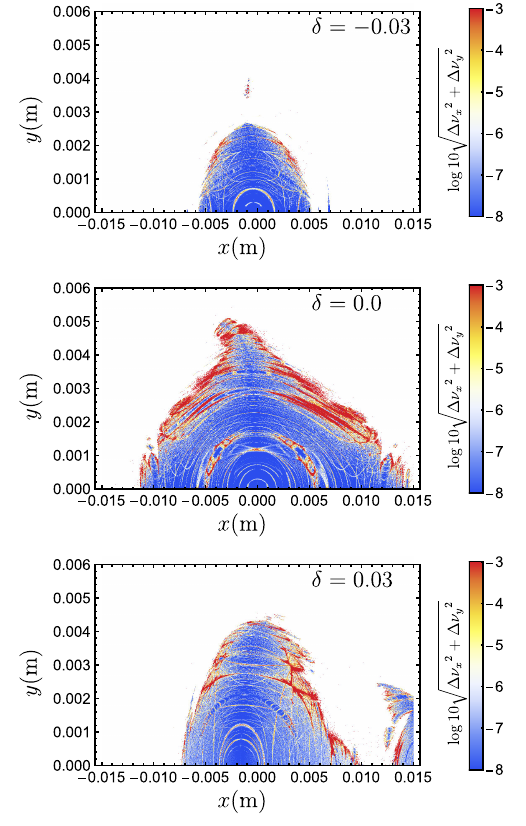
FIG. 18. Frequency map analysis for δ ¼ − 3% (top), δ ¼ 0% (middle), and δ ¼ 3% (bottom). The color represents the differ- ence of the tunes calculated on the first (1024 turns) and the second halves of the tracking time (2048 turns). The blue corresponds to identical tunes, which means regular motion, the red corresponds to large tunes difference and means chaotic motion.